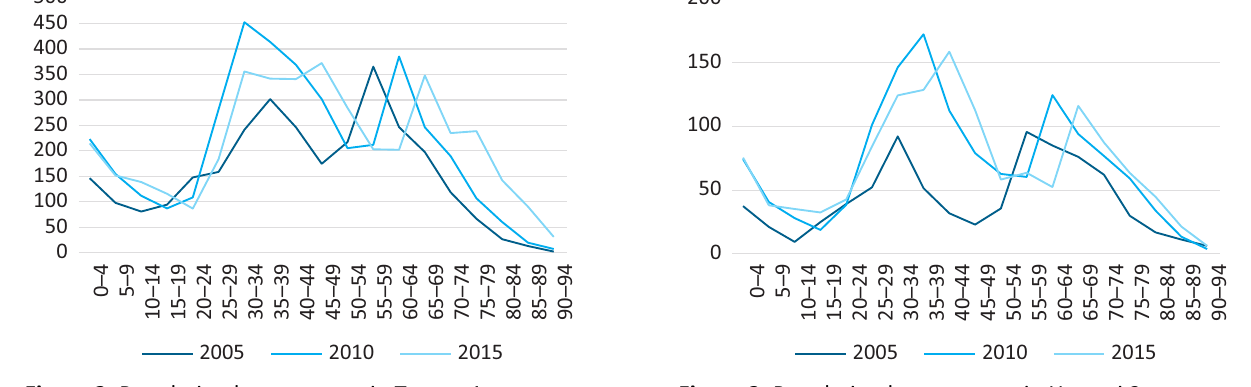
Figure 2. Population by age group in Toyosu 1. Figure 3. Population by age group in Harumi